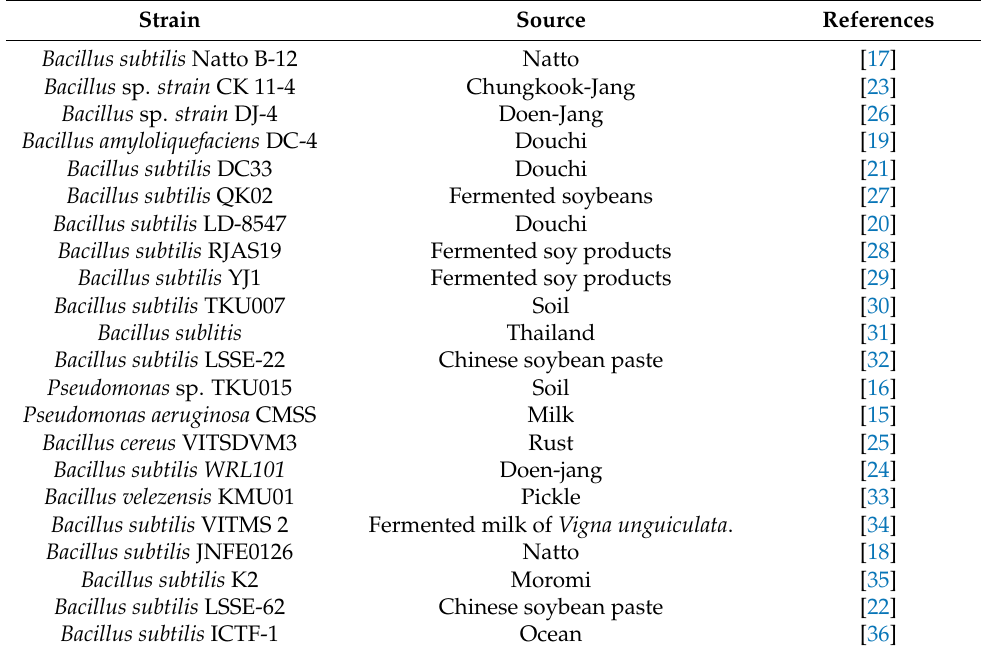
Table 1. Biodiverse sources of